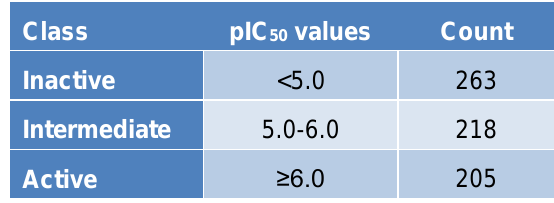
Table 1: Summary of counts of NDM-1 inhibitors along with bioactivity information. After data bal- ancing, all three classes have the same size of 263.